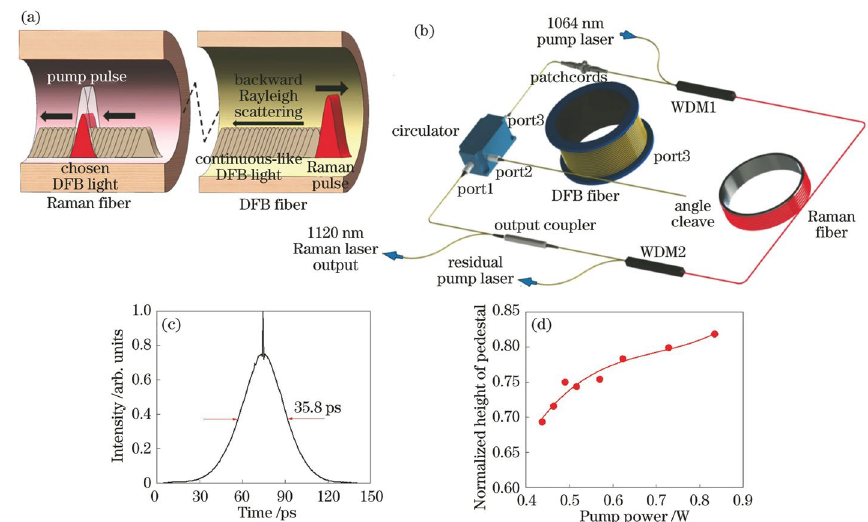
Fig. 12 ( a ) Principle of the self-synchronous Raman fiber laser based on distributed Rayleigh scattering. ( b ) Scheme of the Raman fiber laser. ( c ) Autocorrelation traces of the Raman pulse. ( d ) Normalized autocorrelation pedestal heights as a function of the pump power